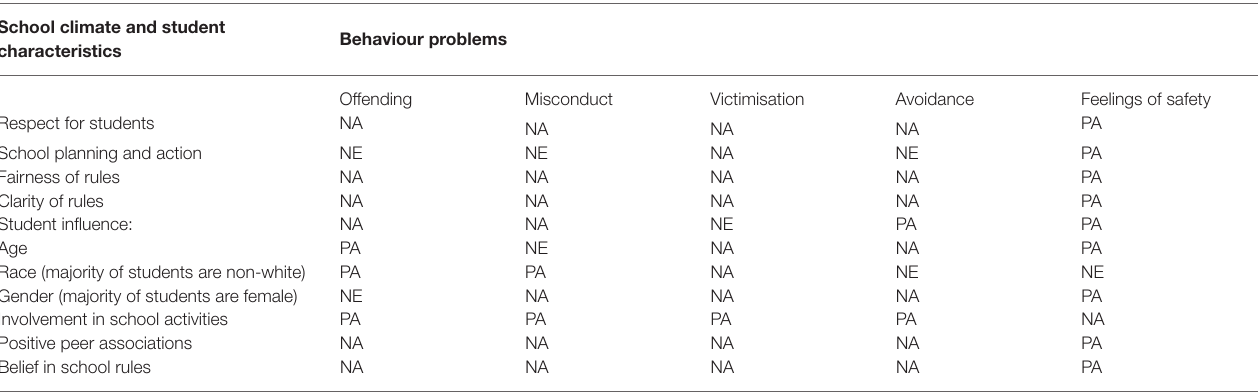
TABLE 3 | Show of associations between school climate, student characteristics and behaviour problems. School climate and student